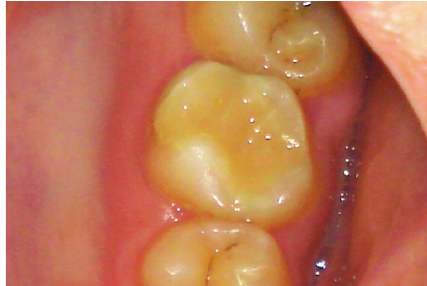
Figure 1: Amalgam restoration with secondary caries in the maxil- lary left first molar.